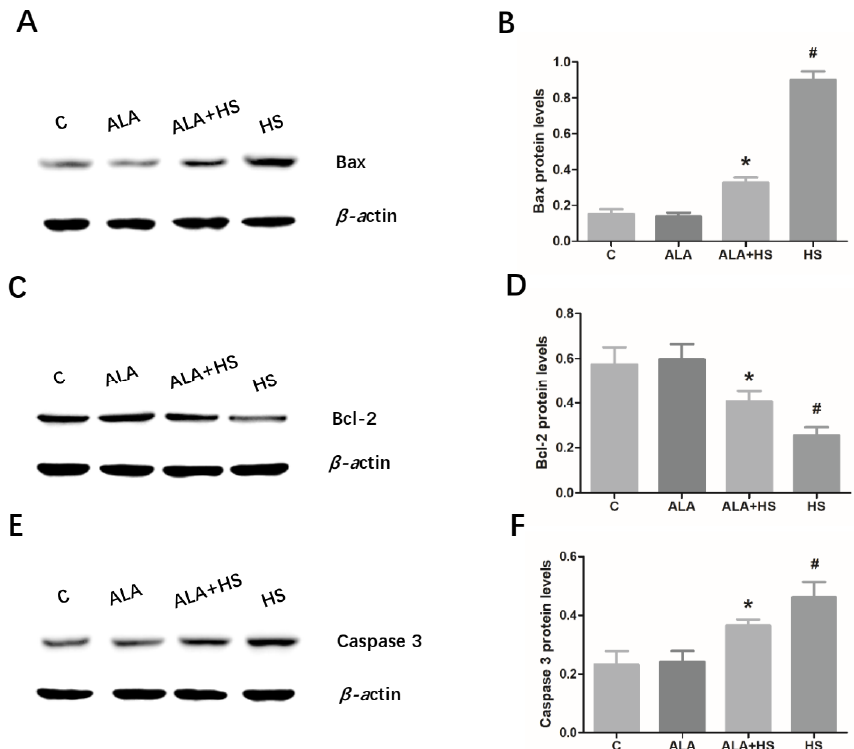
Figure 4. The effect of alpha lipoic acid on the expression of key apoptosis-related modulators in the testes of chickens exposed to heat stress. Western blotting analysis of the expression of apoptosis-related proteins, ( A ) Bax, ( C ) Bcl-2, and ( E ) caspase 3. ( B ) Bax, ( D ) Bcl-2, and ( F ) caspase 3 protein expression levels were normalized to β -actin levels. The statistical analysis results are shown as bar graphs. The data are presented as the mean ± SE of three independent experiments. Note: * p < 0.05 vs. HS group; # p < 0.05 vs. C group.